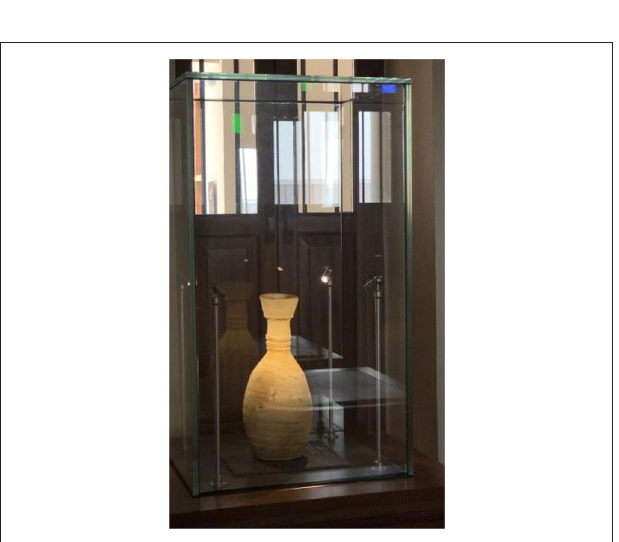
FIGURE 2 | Qudo is an Iranian traditional smoking tool that was brought to Qatar by Iranian immigrants and integrated into Qatari heritage.